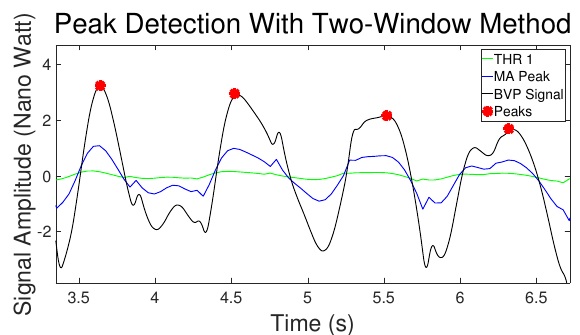
Figure 1. An example of peak detection with Two-Window